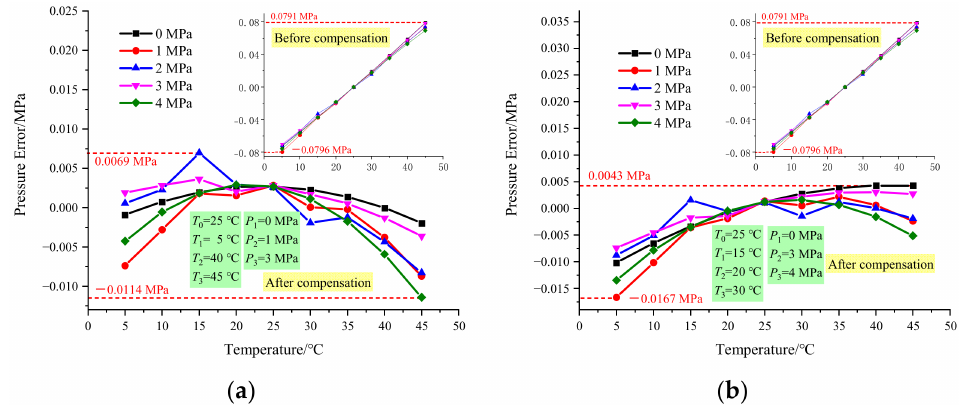
Figure 9. Errors with temperature compensation ( a ) the temperature is 5 ◦ C, 40 ◦ C and 45 ◦ C and ( b ) the pressure is 0 MPa, 3 MPa and 4